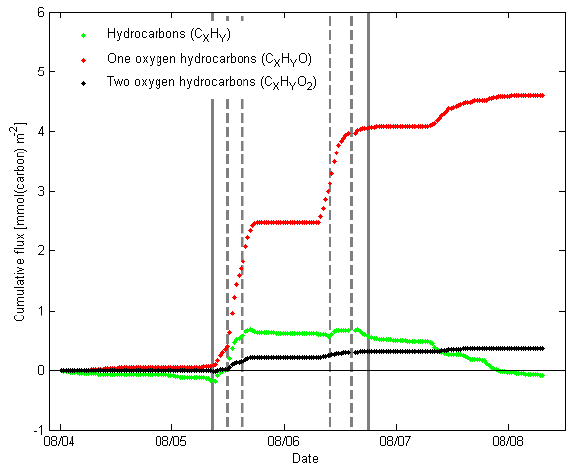
Figure 4. The cumulative sum of the VOC fluxes of pure hydrocarbons, one oxygen containing VOCs and two oxygen containing VOCs from 1 to 8 August 2009. Linearly interpolated values were used to fill gaps in data that were an hour or less. Cut and remove of grass are indicated with continuous gray line, turnings of drying grass with dashed lines.